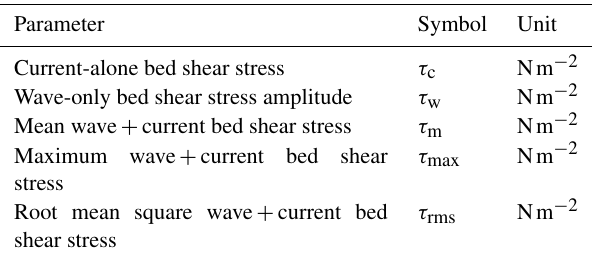
Table A2. Calculation